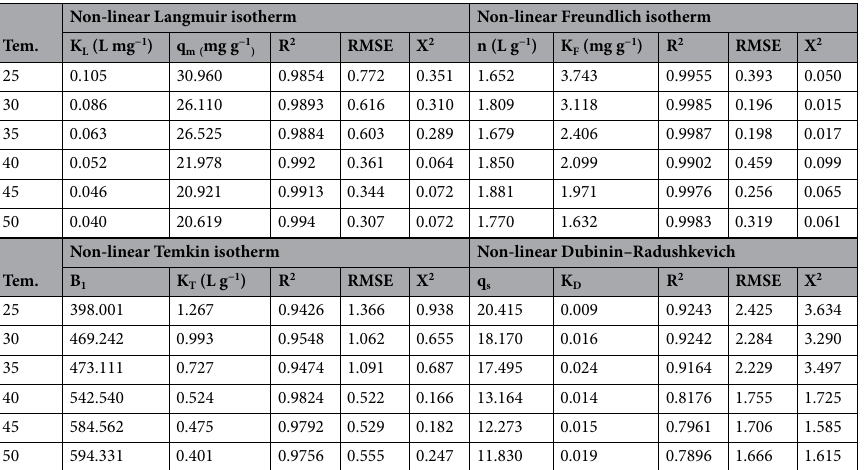
Tem. Table 8. Information of non-linear isotherm models for RR 198 adsorption onto MSW compost ash.